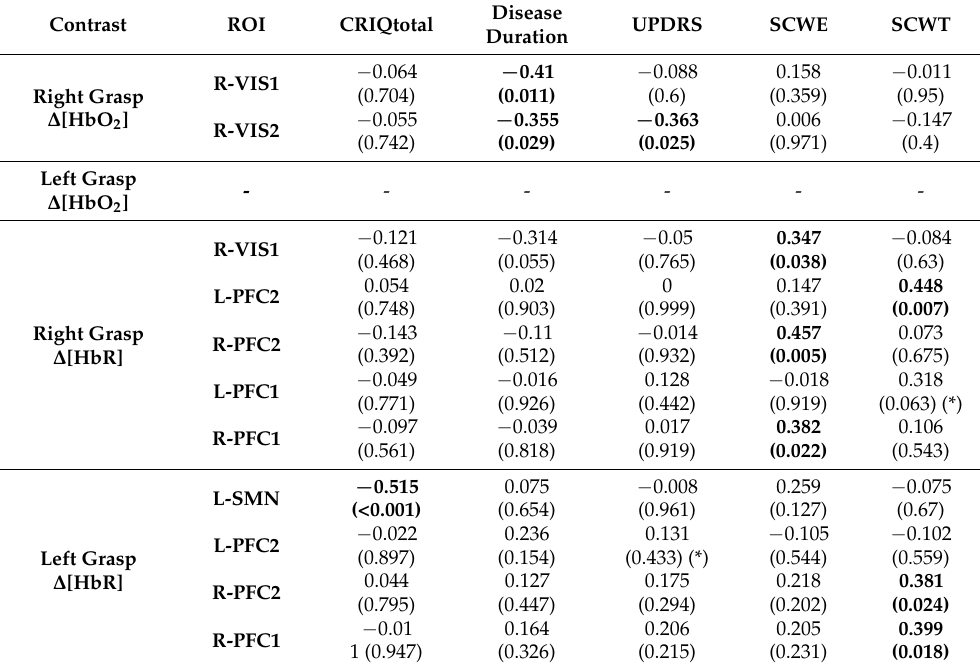
Table 5. Significant results of ROI-based partial correlation analysis between ROI averaged data and patient characteristics at subject level ( p < 0.05), using age as covariate. Results are provided by means of Spearman’s correlation coefficient ρ S ( p value ) . (*) Correlation values were statistically significant when not employing age as covariate. Bold highlights the significant comparisons.